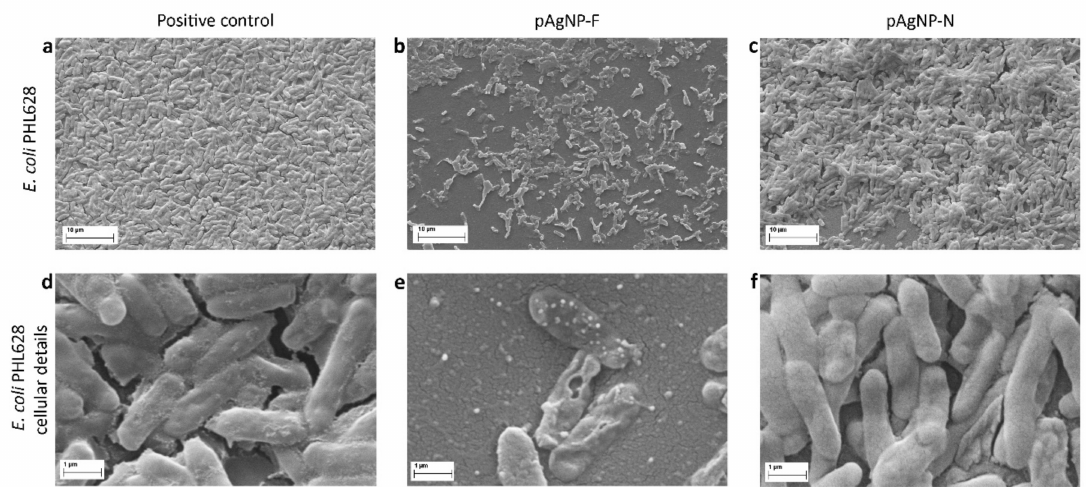
Figure 4. Scanning electron microscopy (SEM) imaging on E. coli PH628 , treated with pAgNP-F and pAgNP-N in pre-biofilm conditions. ( A ): positive control (incubation in biofilm-inducing medium); ( B ): treatment with 250 µ M pAgNP-F; ( C ): treatment with 250 µ M pAgNP-N; ( D – F ): same as ( A – C ), respectively, at larger